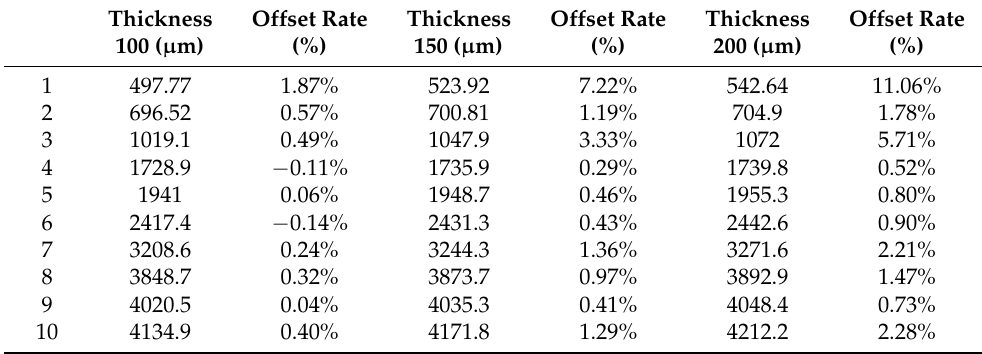
Table 6. First 10 natural frequencies/Hz of 304 stainless steel clamps coated with different thicknesses of Z r O 2 -PTFE.